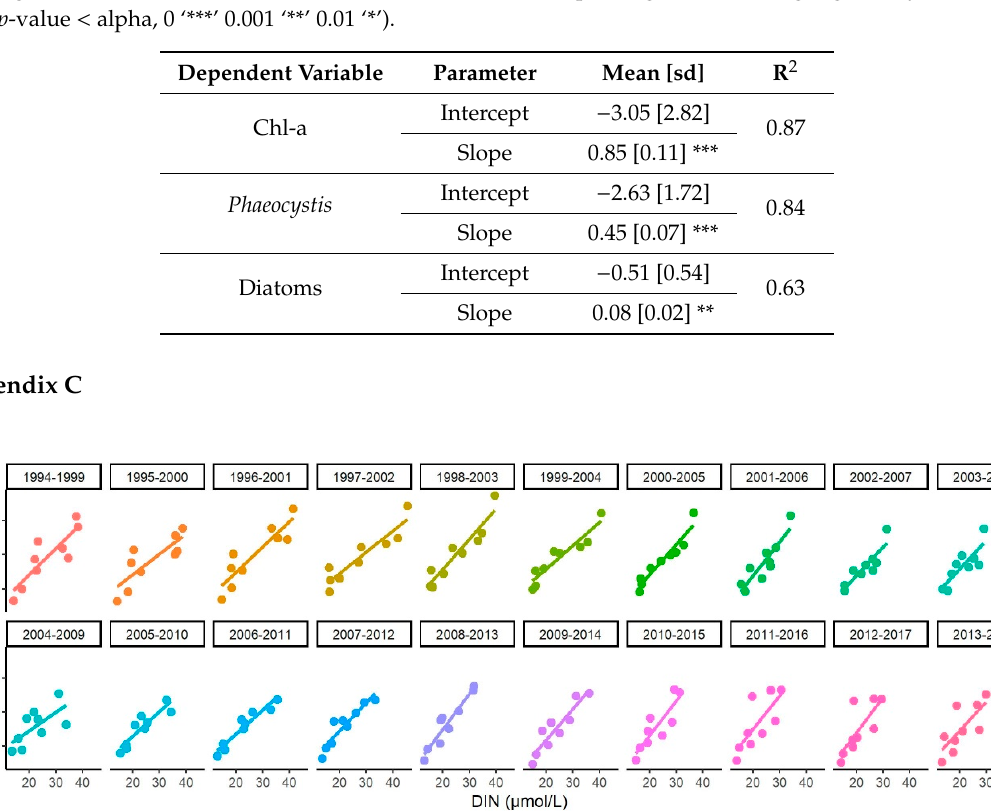
Table A1. Statistics of the regression lines for DIN~Chl-a, DIN~ Phaeocystis and DIN~Diatoms (statistical significance of correlations are associated to a threshold alpha: significance is highlighted by *